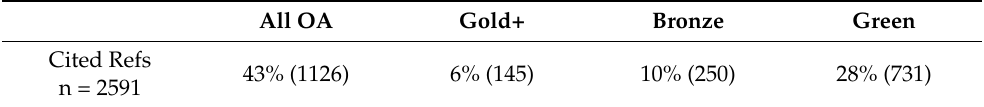
Table 3. Cited references by OA